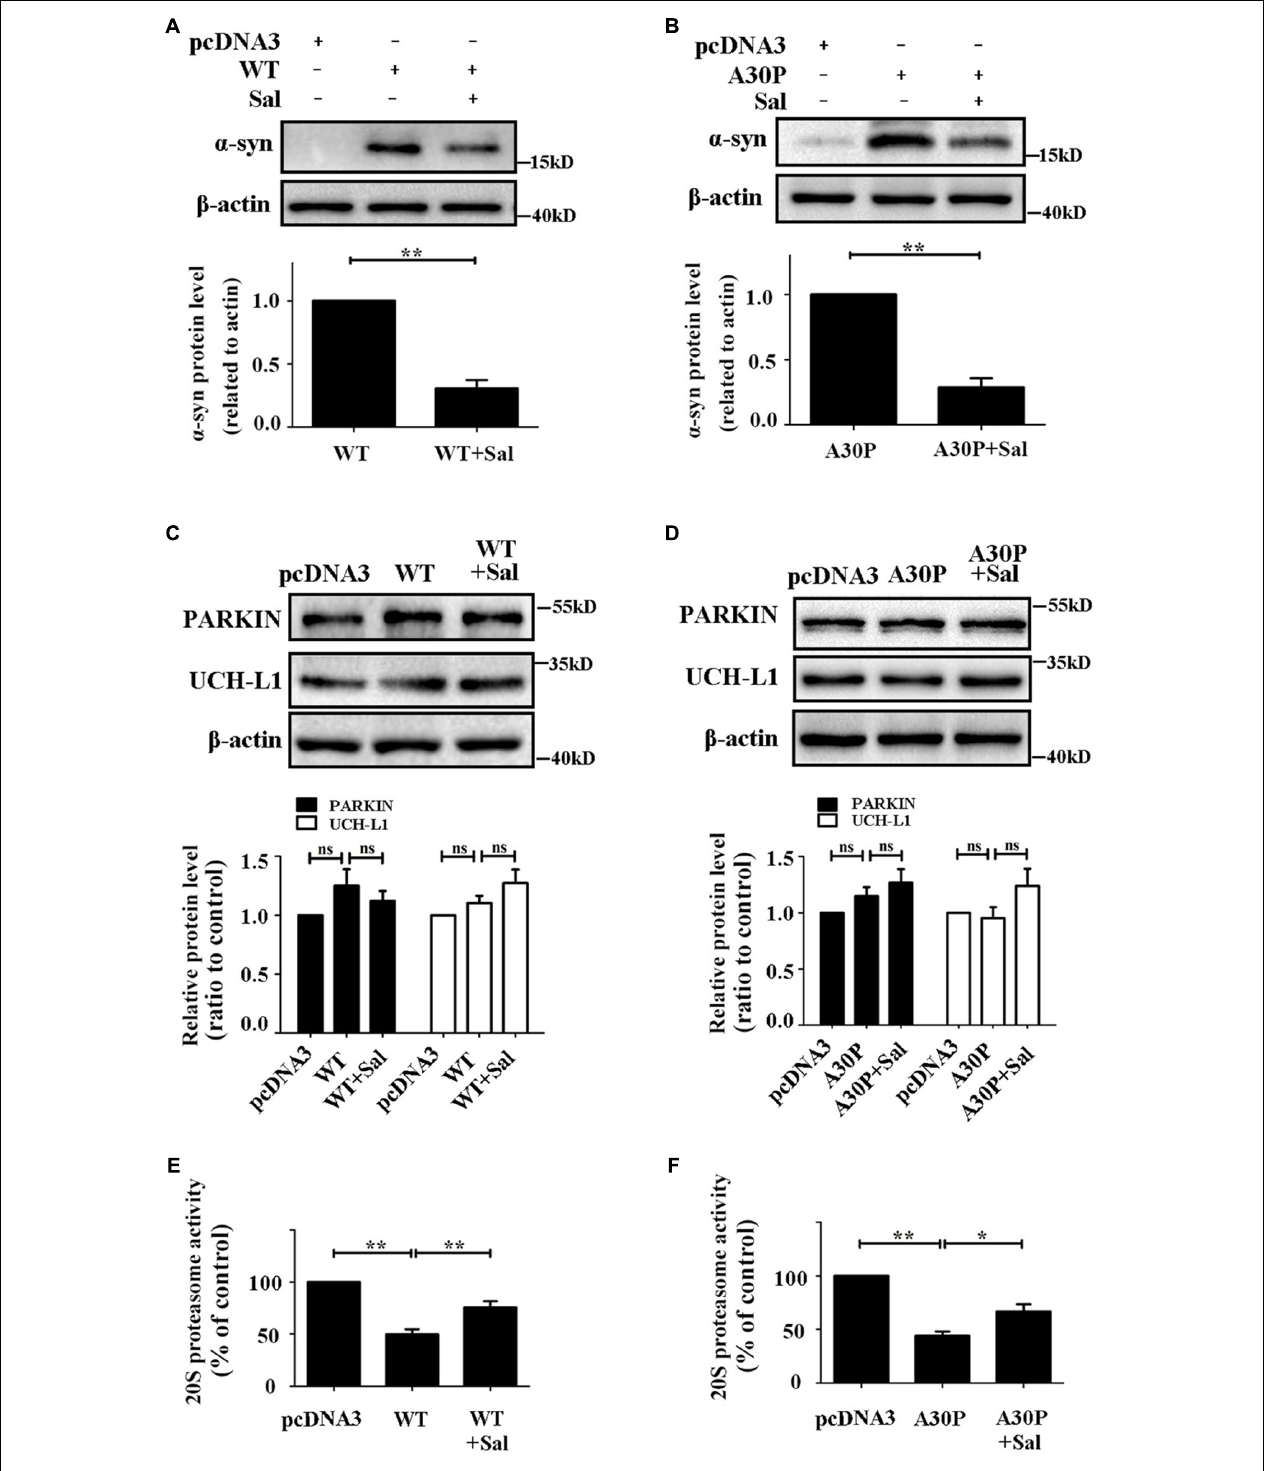
FIGURE 5 | Sal promoted α -syn clearance and recovered the 20S proteasome activity in WT/A30P- α -syn-transfected SH-SY5Y cells. SH-SY5Y cells were transfected with WT/A30P- α -syn plasmids for 24 h after which Sal (40 µ M) was added for an additional 24 h. (A,B) Western blot analysis of α -syn protein levels. (C,D) Immunoblot levels of PARKIN and UCH-L1. (E,F) Proteasome activity assay analysis of 20S proteasome activity. Data are shown as the mean ± SEM. Statistical significance was analyzed by one-way analysis of variance (ANOVA). A two-tailed Student’s t -test was performed for comparisons between two groups. Each experiment was repeated three times independently. ∗ P < 0.05; ∗∗ P < 0.01, ns: no significance.